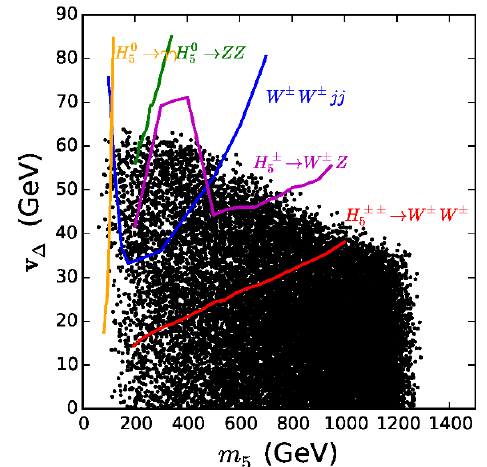
Figure 4 . Constraints from searches for quintuplet Higgs bosons on the v above exclusion curves are